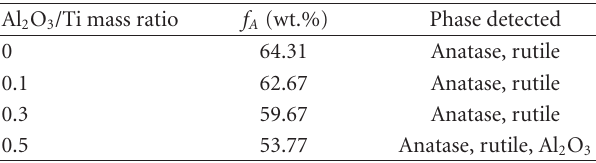
Table 1: Crystal phases of Al-doped TiO 2 synthesized at various Al 2 O 3 /Ti mass